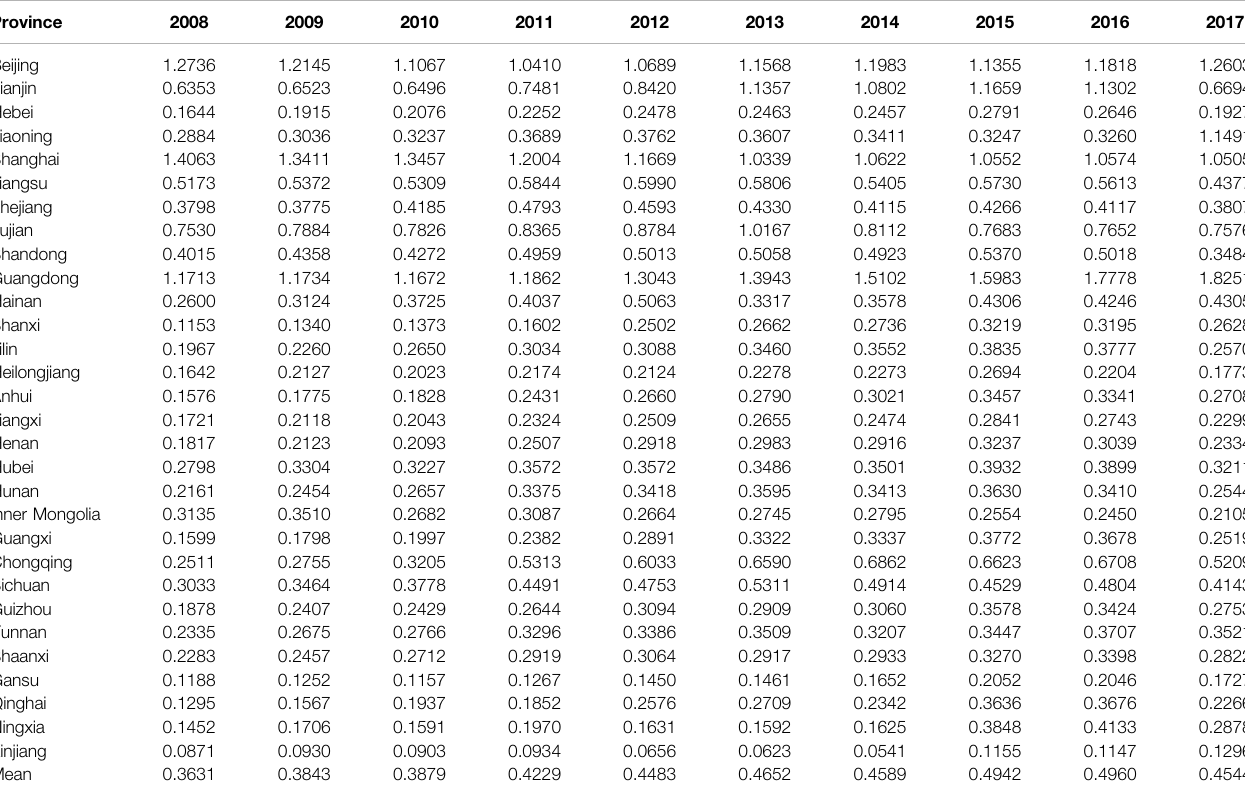
TABLE 3 | Environmental ef fi ciency of China ’ s high-tech industry from 2008 to 2017.